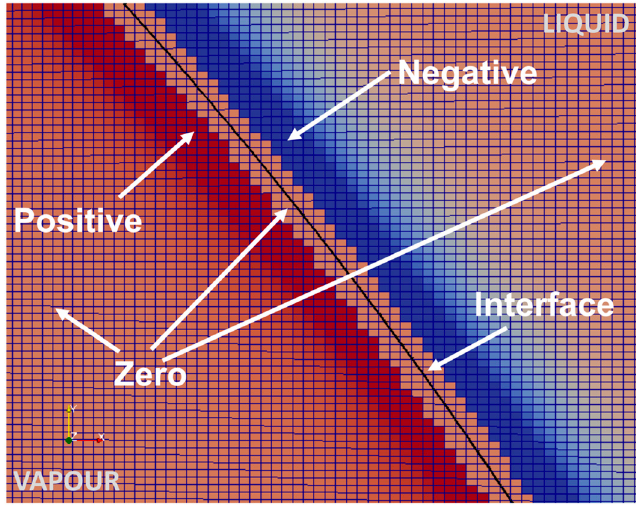
Figure 1. Distribution of the final source terms in the computational domain for the case of an evaporating bubble.